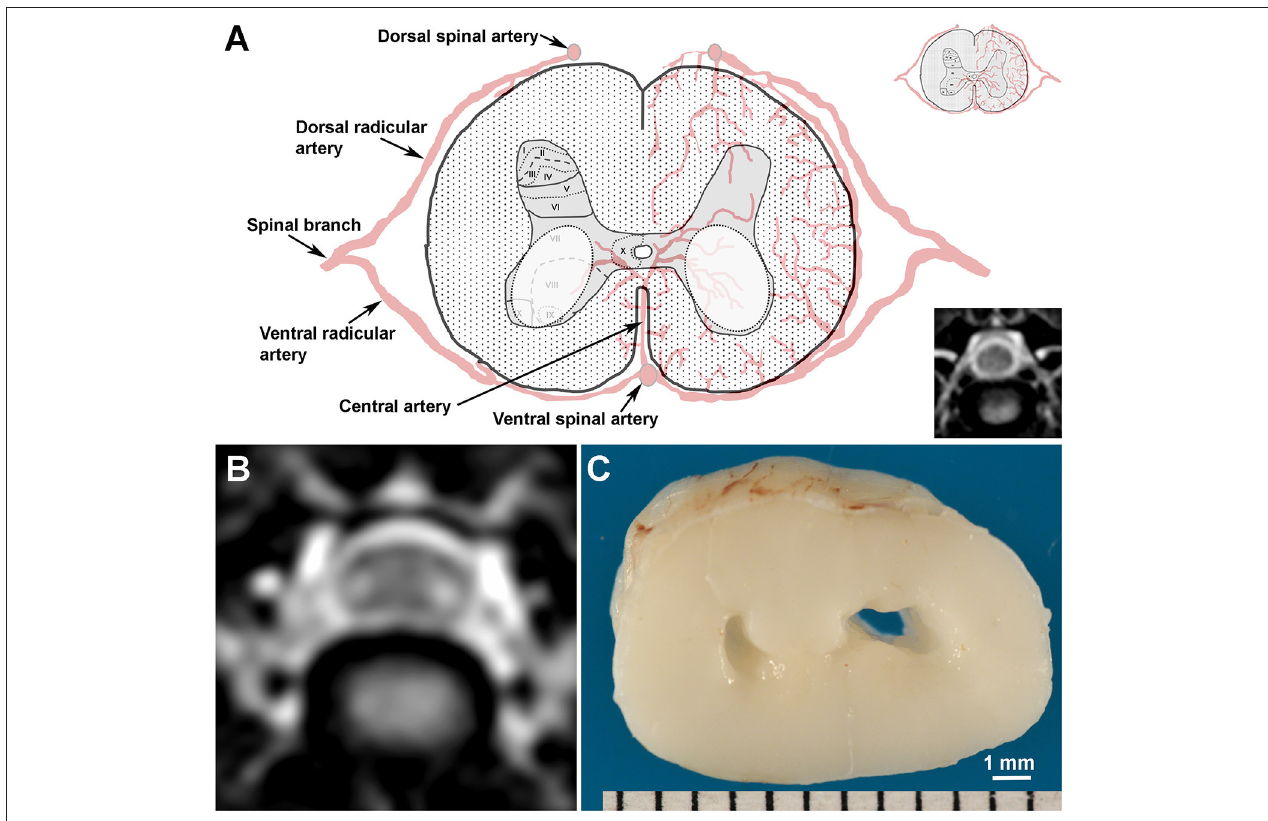
FIGURE 1 | Topography, MRI, and gross pathological appearance of canine snake eye myelopathy (SEM)-like phenotype. (A) Schematic and normal T2W transverse MR image (lower inset) of canine C5 spinal cord segment illustrating putative arterial supply and Rexed laminar structure of the gray matter (upper inset). SEM-like lesions appear as bilaterally symmetric lesions (white dashed ovals) distributed in laminae VI-IX of the gray matter. (B) Transverse T2W MRI through the cranial aspect of C5 from Case 1 with the SEM-like phenotype demonstrating bilaterally symmetric intramedullary hyperintensities in the ventral horn gray matter and dorsoventral flattening of the spinal cord. (C) The SEM-like phenotype is pathologically characterized by bilateral cavitations in the C5 ventral horns and poliomalacia; Case